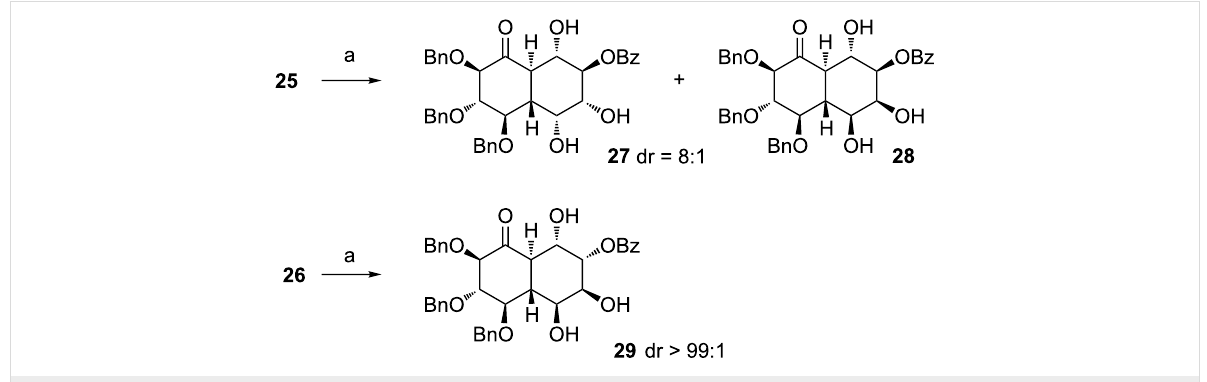
As a result, in the case of diolefin 25 as substrate, a separable mixture of diols (dr = 8:1; 27 being the major isomer) was ob- tained in fair yield (56%). The same procedure applied to com- pound 26 resulted in the formation of virtually one diastereoiso- mer 29 (53%). The structure of all compounds was assigned by 2D-NOESY experiments (Figure 2). In the case of both olefins, syn -dihydroxylation proceeded from the less congested face of the double bond ( anti in the relation to the neighbouring benzoyl